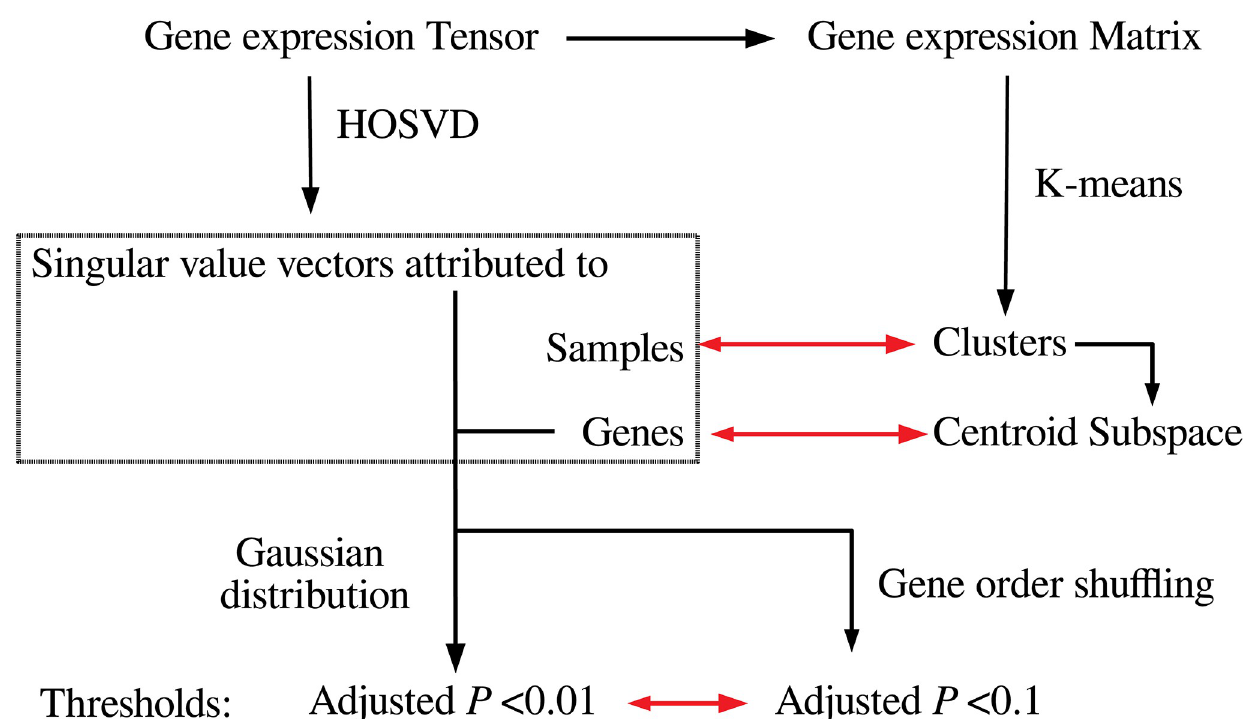
Fig 7. Discussion of work flow used in this study. Tensor decomposition (HOSVD) was applied to tenors and using obtained singular value vectors assumed to obey Gaussian distribution, P -values are attributed to genes. The genes associated with adjusted P -values less than 0.01 are selected. P -values are also computed by shuffling and the genes associated with adjusted P -values less than 0.1 are well coincident with the genes selected by HOSVD. The correspondence between singular value vectors and K-means applied to unfolded matrices is also discussed.